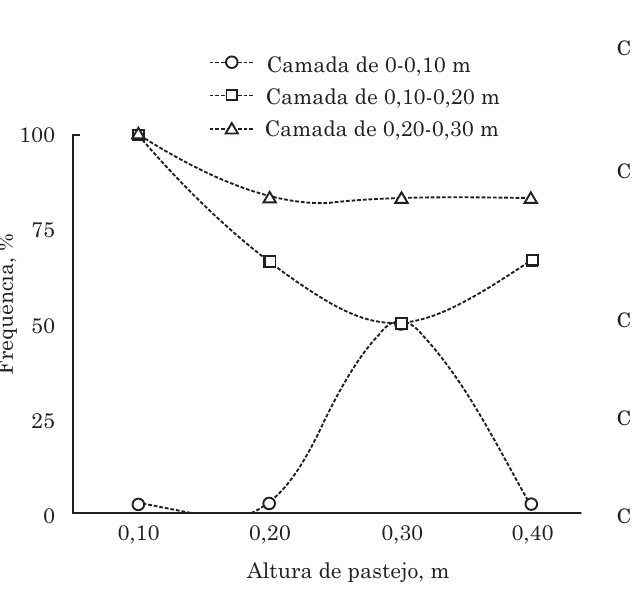
Figura 4. Frequência relativa de amostras de solo com Dse Dsc para os tratamentos de altura de pastejo (0,10; 0,20; 0,30; e 0,40 m e sem pastejo) nas camadas de 0-0,10; 0,10-0,20; e 0,20-0,30 m do Latossolo Vermelho distrófico típico, em sistema de integração